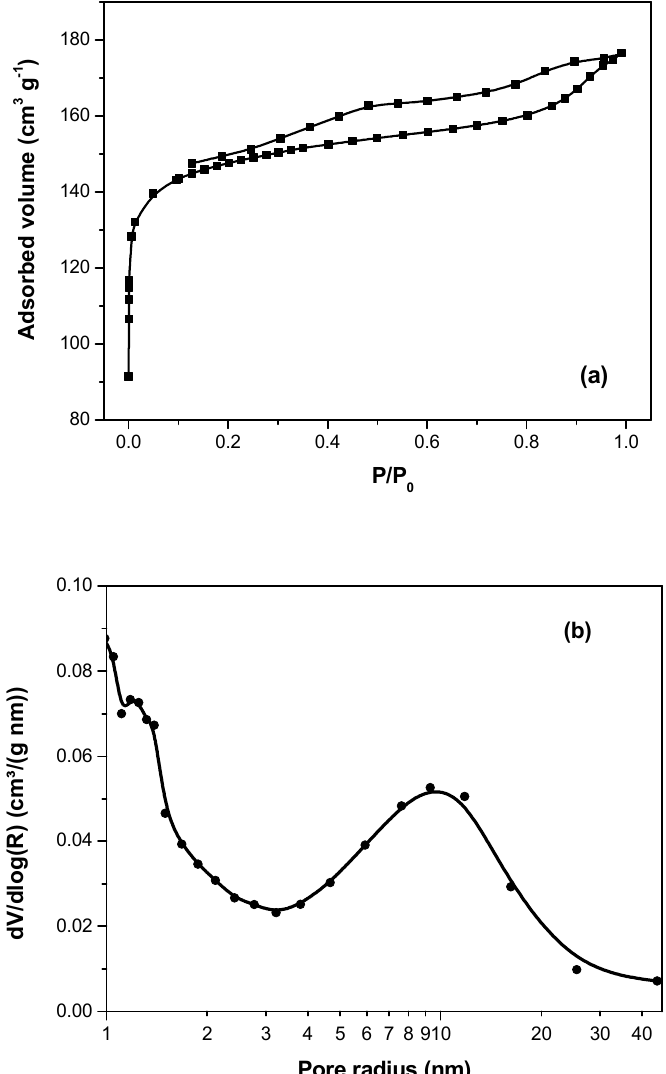
Figure 4. N 2 adsorption/desorption isotherm ( a, balck squares ) and pore size distribution ( b, black dots ) of c(RF@F). The results show that natural fiber with resorcinol-formaldehyde composite forms hierarchical carbon pore structures from different scaffolds. Micrometric millipore allows easy access into the monolith material and bimodal mesopores and micropores that contributes to obtaining a high surface area but remains good accessibility to the nanometric scale. The values are lower than those obtained for activated carbon from cotton (>1000 m 2 g − 1 [91]), but the large mesoporosity allows electrolyte penetration and large specific capacitances (see Section 3.3.4).